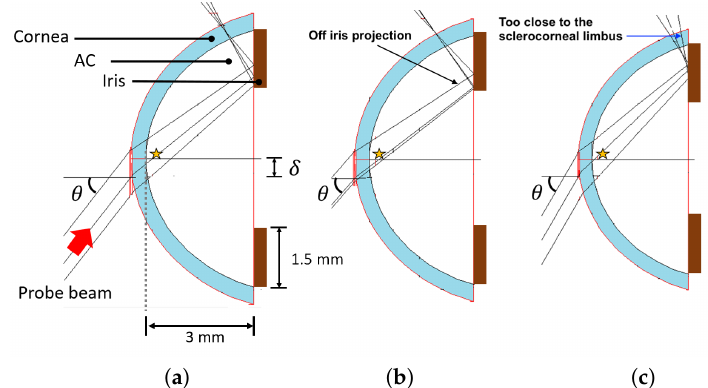
Figure 5. Simulation on WinLens3D Basic of the probe beam propagation through the AC. ( a ), ( b ), and ( c ) are the results for incident angles of 52 ◦ , 49 ◦ , and 60 ◦ , respectively. The star indicates the cavitation bubble